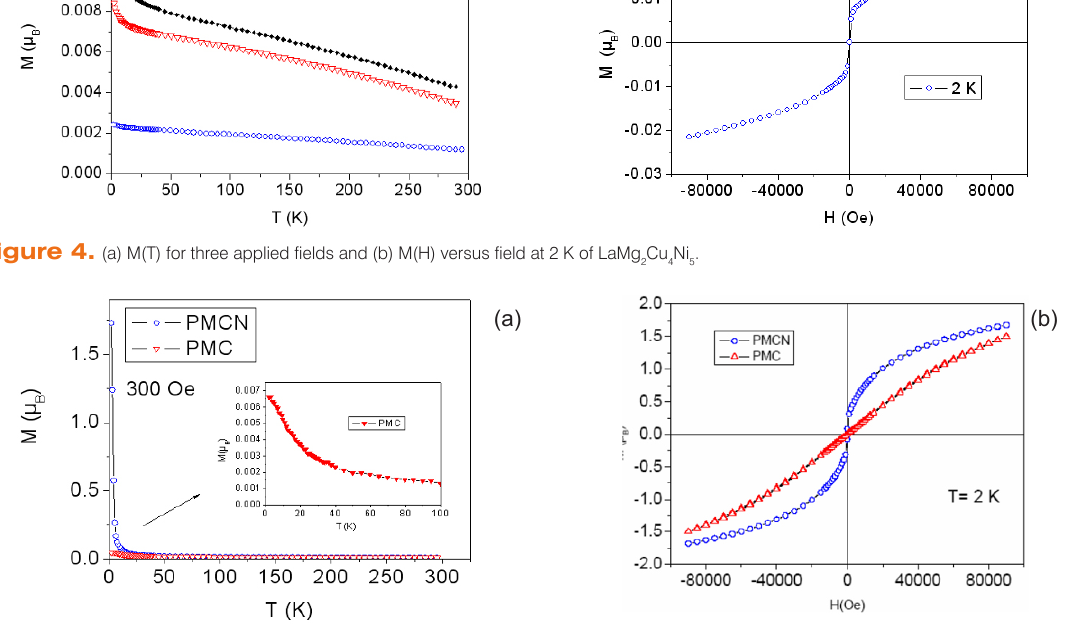
Cu (PMC) and PrMg 2 9